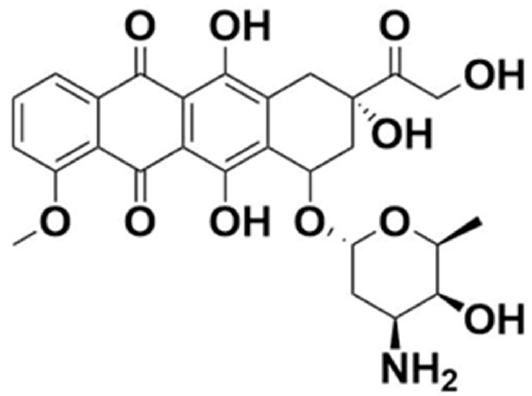
Figure 1. Chemical structure of doxorubicin.